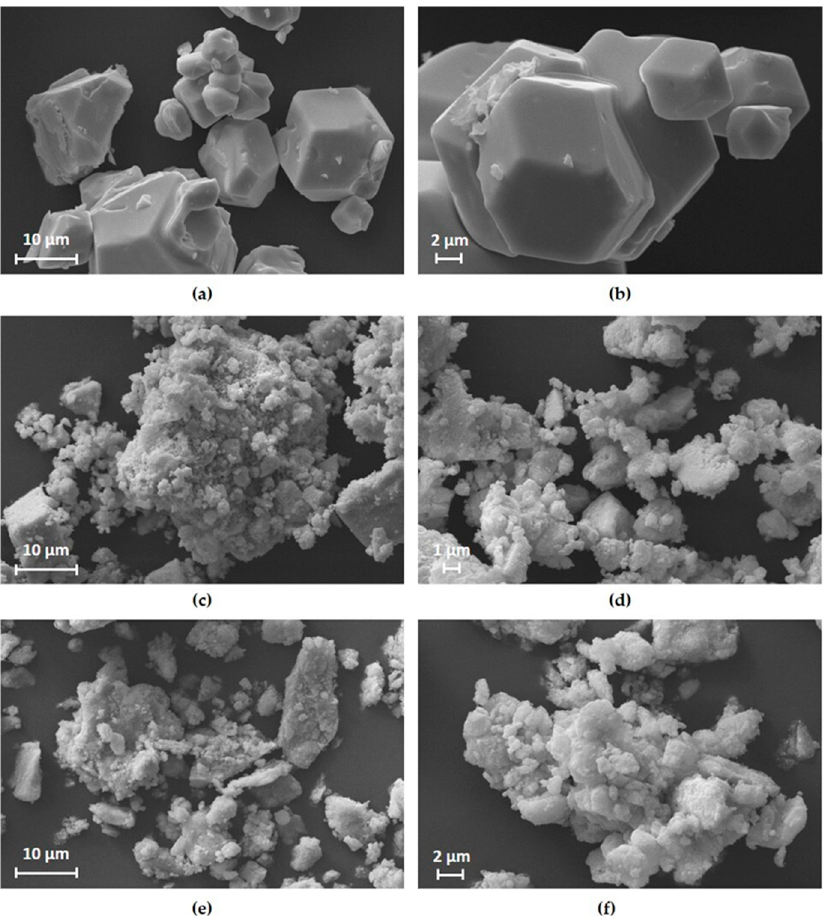
Figure 3. Scanning electron microscopy (SEM) images, at 5 k×and 10 k× magnification, of ( a , b ) as- prepared MAPbI 3 , and that after ( c , d ) 120 and ( e , f ) 240 h of ball-milling.